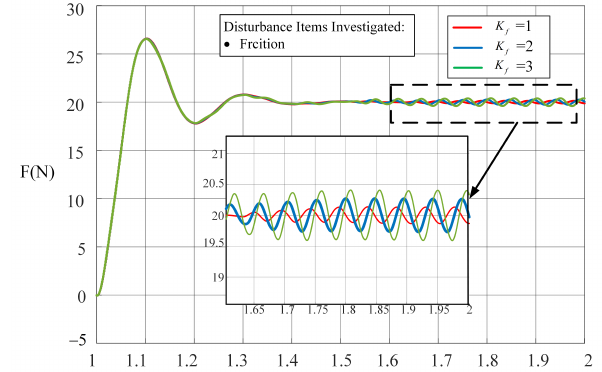
Figure 11. The force step responses of FOIC with friction